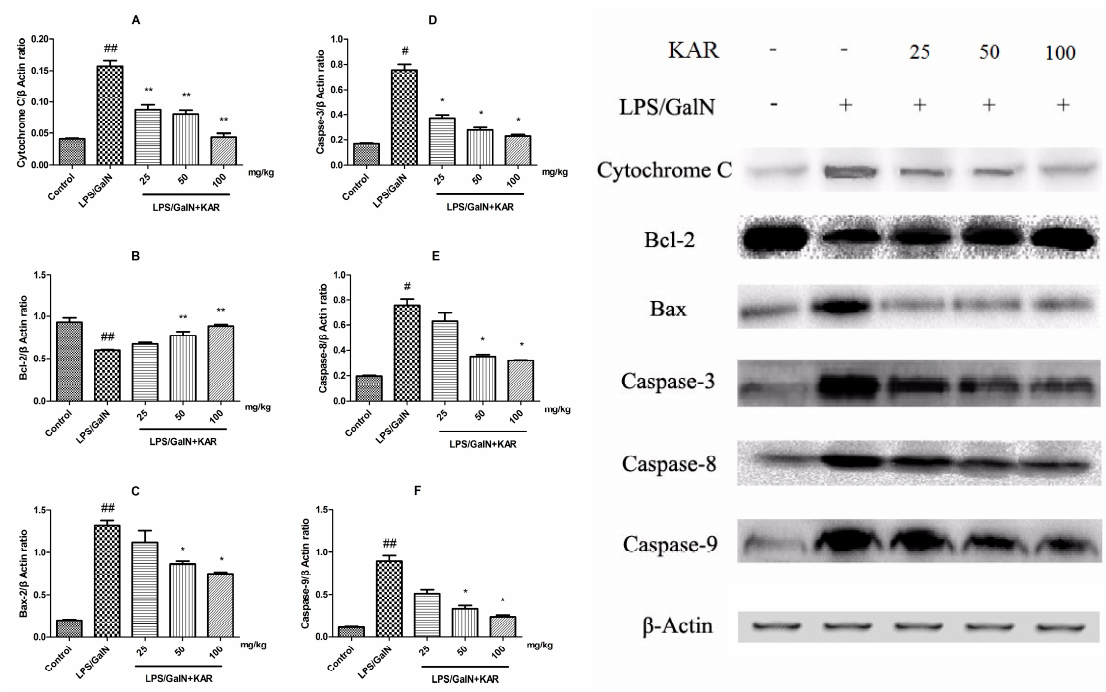
Figure 5. The expression of apoptotic factors, such as cytochrome C ( A ); Bcl-2 ( B ); Bax ( C ); caspase-3 ( D ); caspase-8 ( E ); and caspase-9 ( F ); was detected by immunoblotting of the liver tissues of each group 6 h after D-GalN/LPS administration. The data are normalized to that of β -actin and represent the mean ± SD; * p < 0.05, ** p < 0.01 compared to the FHF model group, and # p < 0.05, ## p < 0.01 compared to the control group.